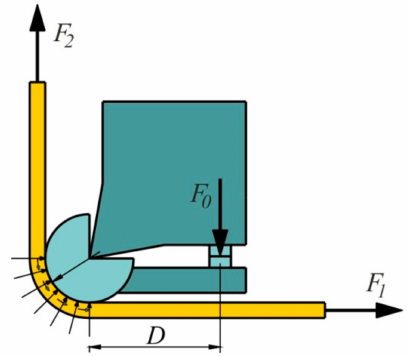
Figure 20. Equilibrium of the torque in the BUT, prepared based on